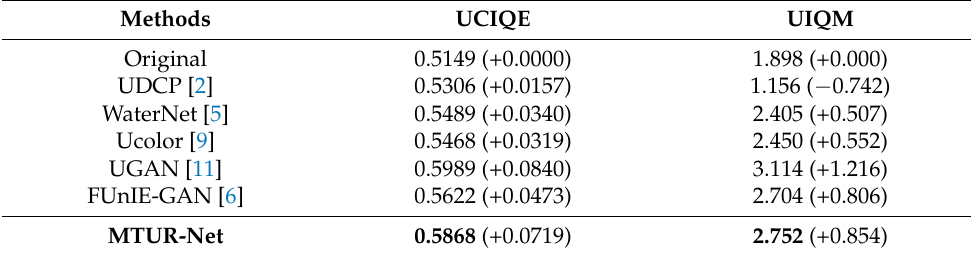
Table 2. UCIQE [27] Scores and UIQM [28] Scores of Different Methods on Test-C60.